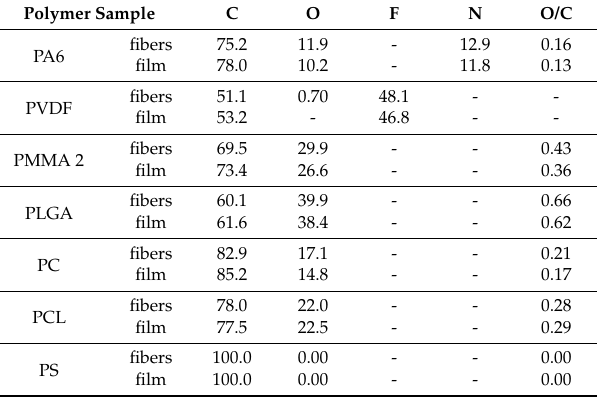
Table 7. X-ray photoelectron microscopy (XPS) results, expressed as % atomic, for polymer films